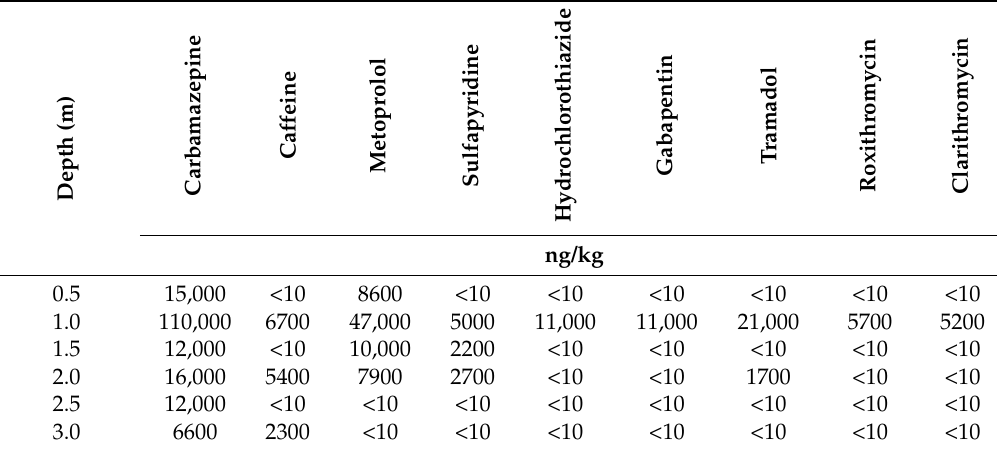
Table 7. Detected pharmaceutical concentrations in the unsaturated